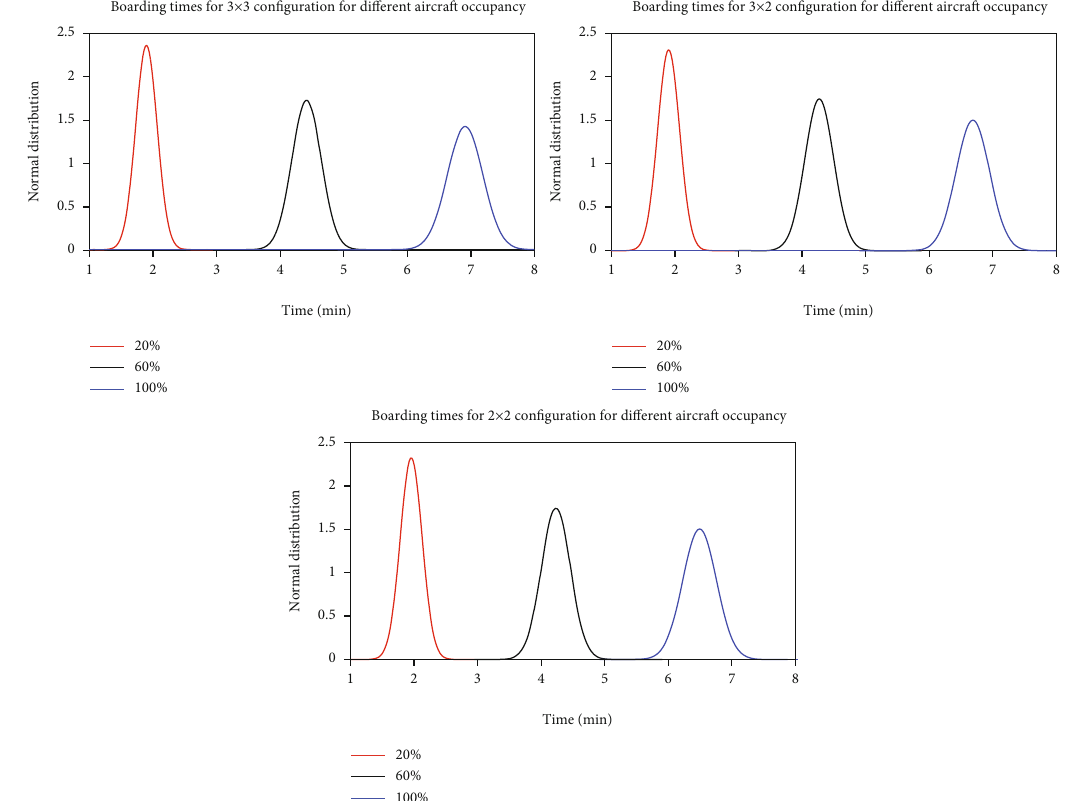
Figure 7: Fitted normal distribution curves for the three aircraft con fi gurations using the outside-in boarding strategy for di ff erent % of aircraft